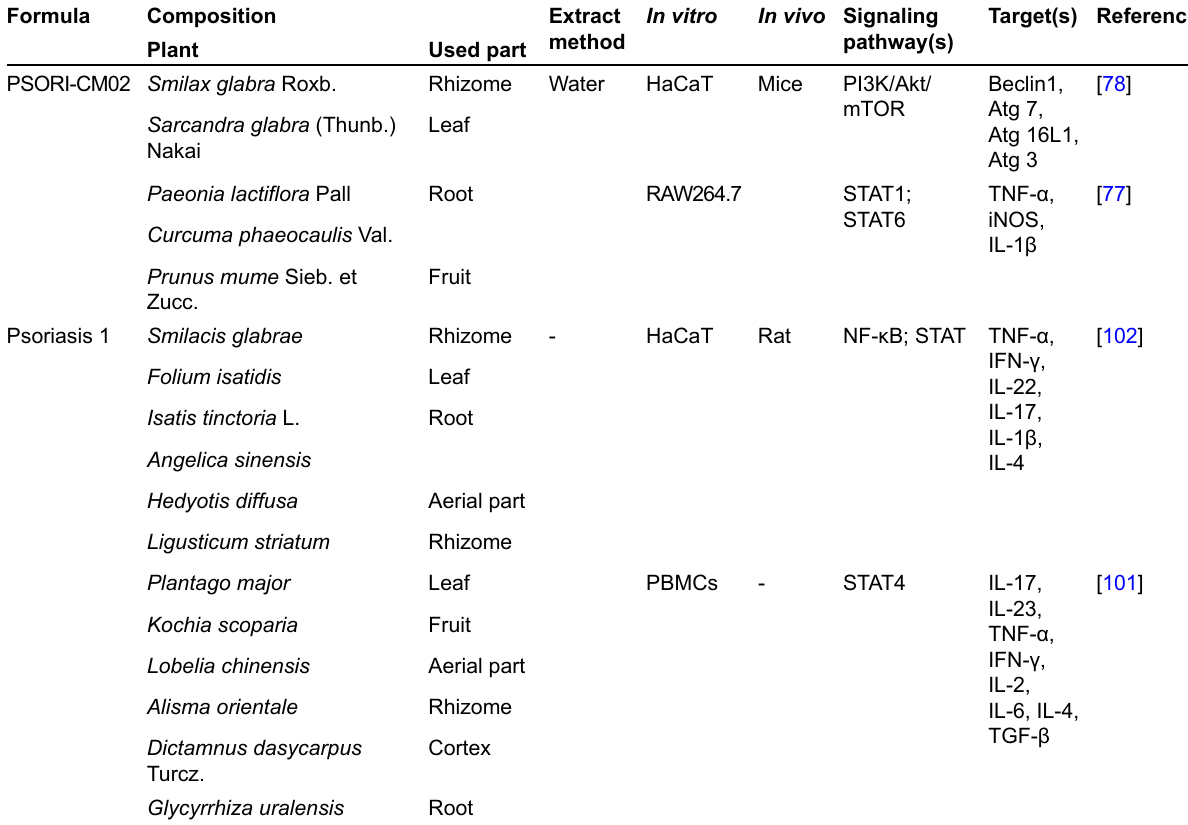
Table 3. The effects of herbal formulas on psoriasis ( continued )